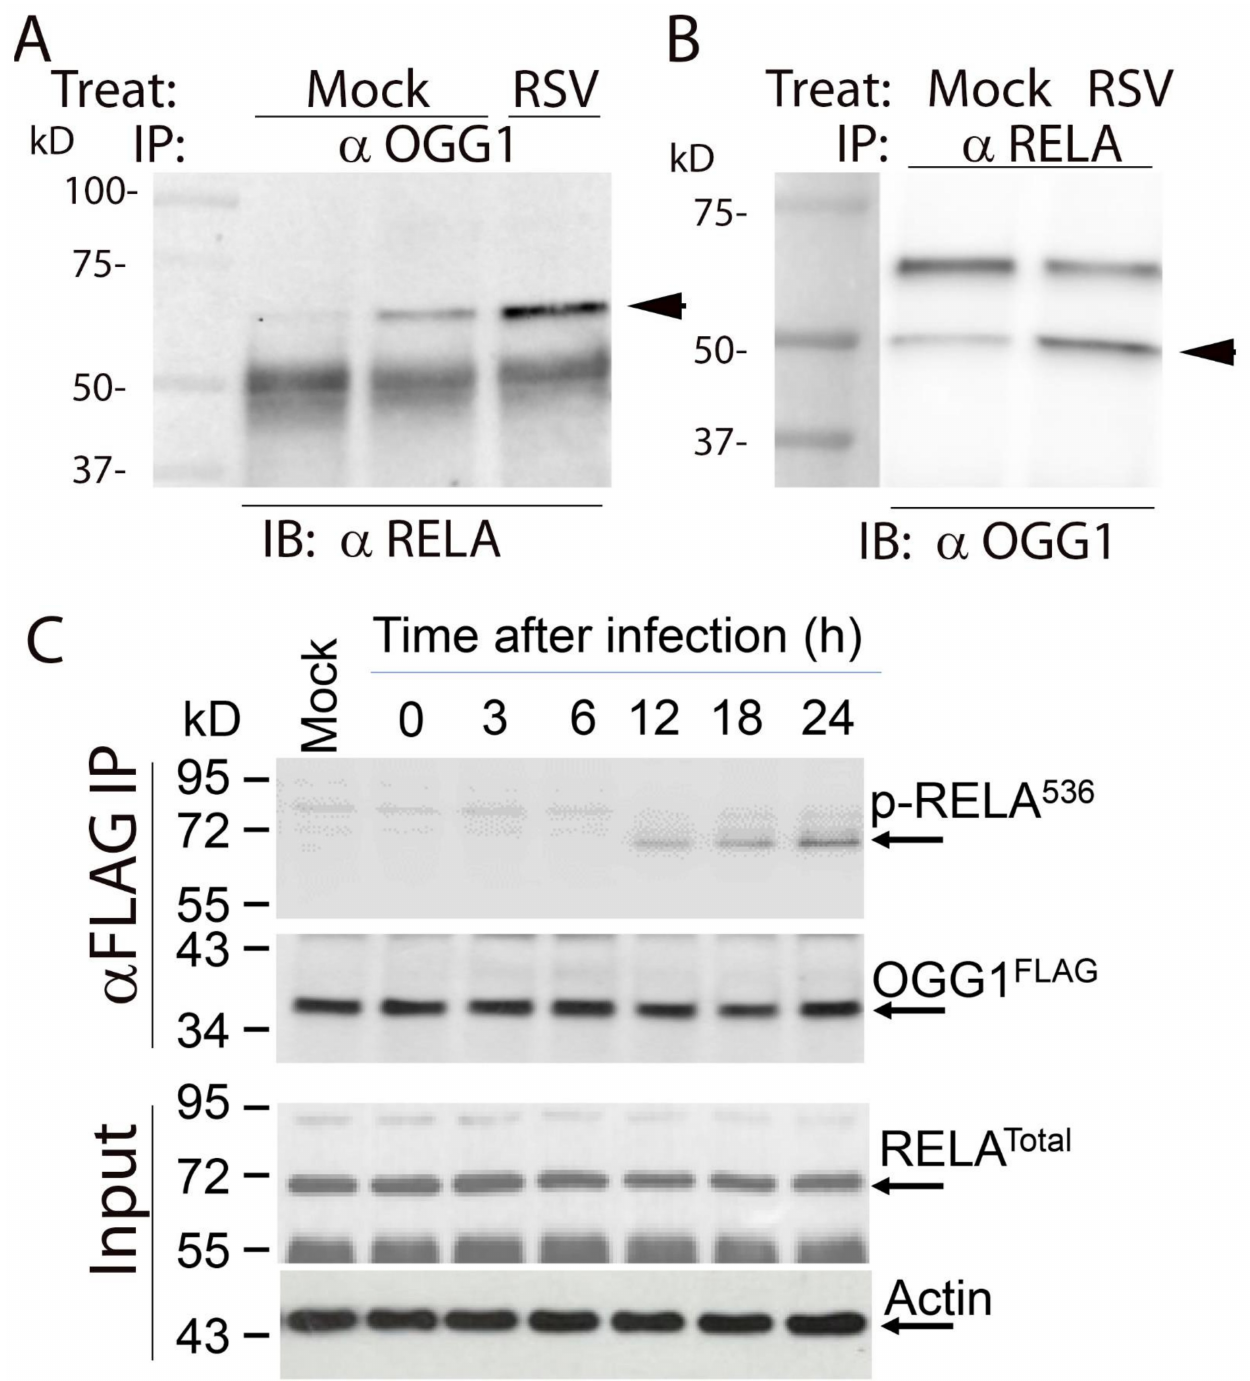
Figure 9. RSV induces phospho-Ser536 RELA binding to OGG1. ( A ) Co-immunoprecipitation (Co-IP) experiments. hSAECs lysates from mock- or RSV-infected cells were IPed with anti-OGG1 antibody. The immune complexes were fractionated and subjected to IB with anti-RELA. Arrowhead shows the 65 kDa RELA. ( B ) Co-IP of mock- or RSV-infected cells with anti-RELA Ab. Immune complexes were fractionated and subjected to IB with anti-OGG1. Arrowhead indicates the 50 kDa OGG1. ( C ) Lysates were prepared from FLAG-M2-OGG1-expressing A549 cells after various times of RSV infection and IPed with anti-FLAG M2 beads. Top panel, immune complexes were stained with anti-phospho-Ser536 RELA. The blot was stripped and re-probed to confirm equivalent levels of FLAG-OGG1 capture. Bottom panels are input showing total RELA and b actin. Molecular-weight markers are kDa